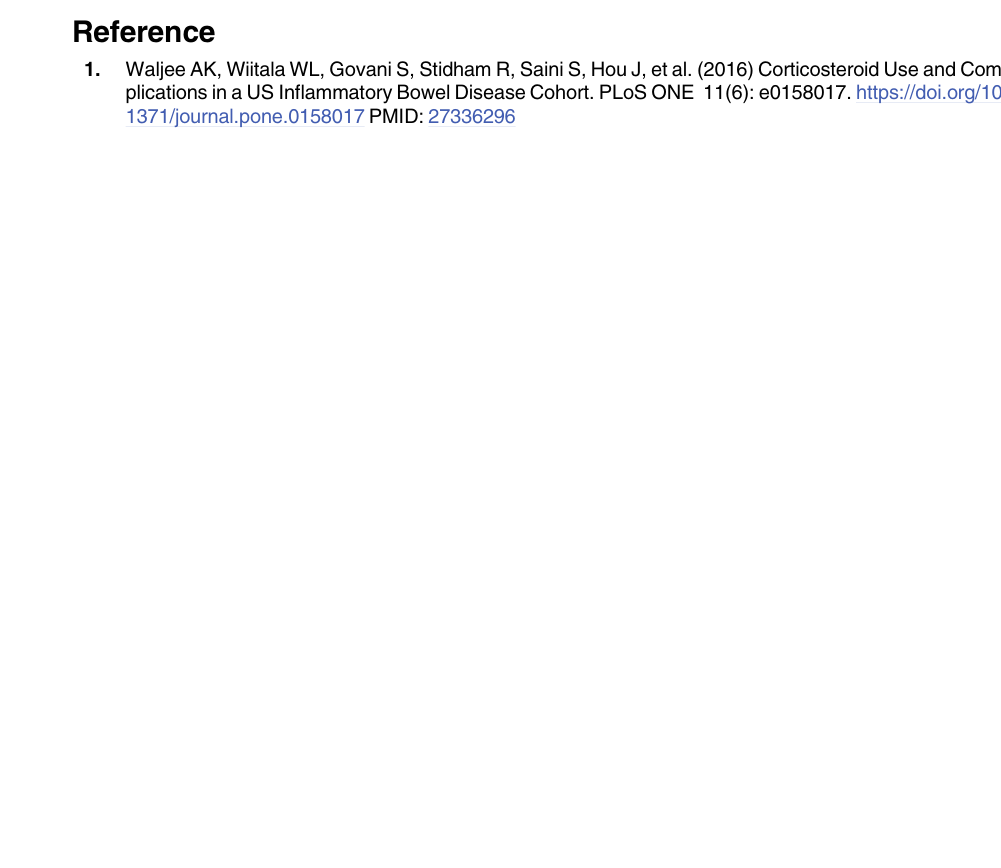
S1 Tables. Supplementary results of patient characteristics and patterns of corticosteroid use. Supplementary Table A: Patient Characteristics (N = 30,456). Supplementary Table B: Patterns of Corticosteroid user characteristics among Veteran with and without corticoste-